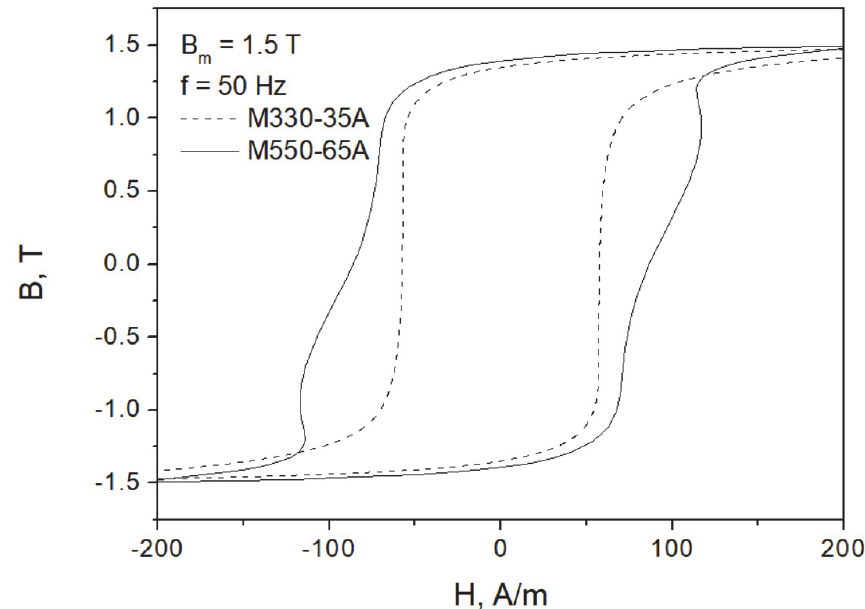
Figure 1. Measured hysteresis loops for two NO steel grades at B m = 1.5 T.